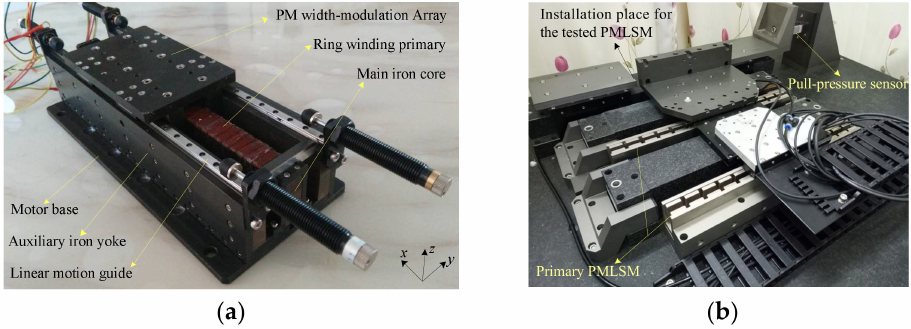
Figure 11. Prototype: ( a ) motor, ( b ) test